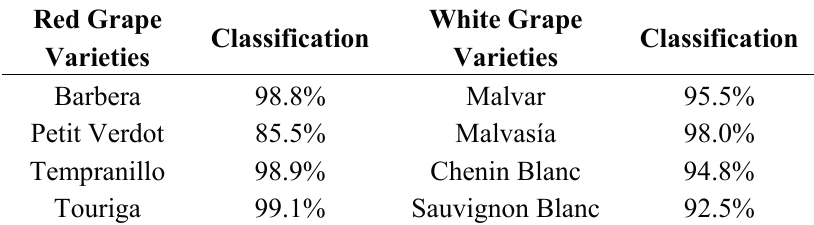
Figure 9. PCA analysis for the samples collected in 2012. ( a ) 14 of September for white varieties; ( b ) 10 of September for red varieties. Table 3. Classification by a PNN for samples collected in